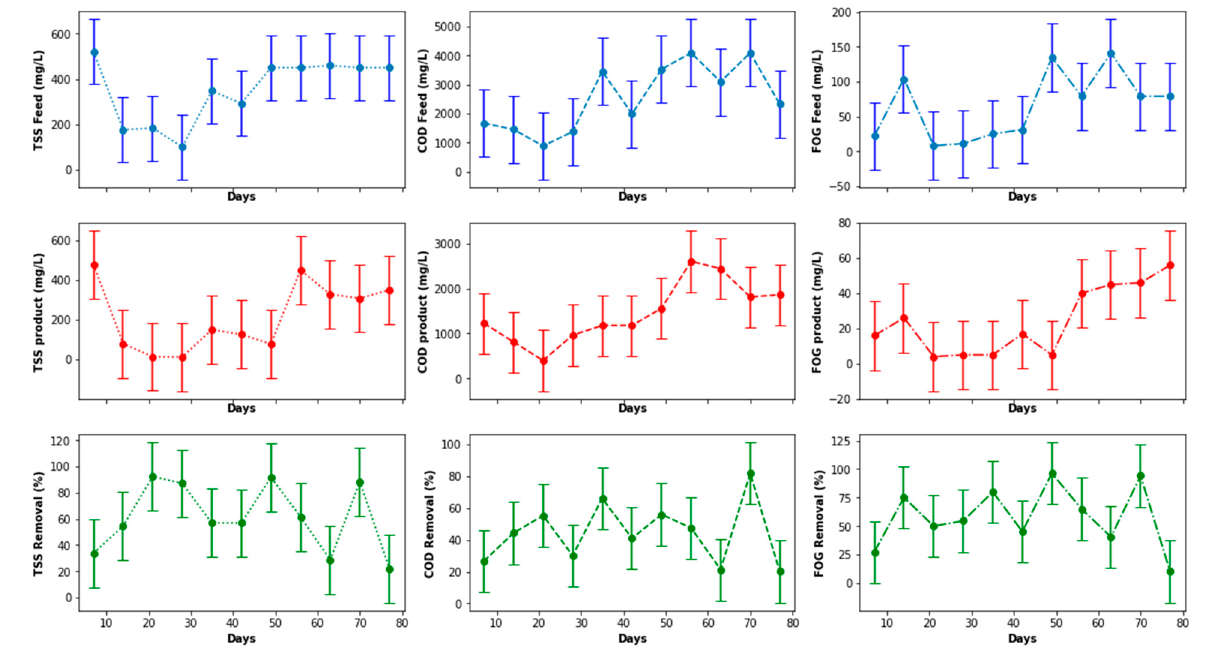
Figure 9. EGSB performance with respect to COD, TSS, and FOG removal.